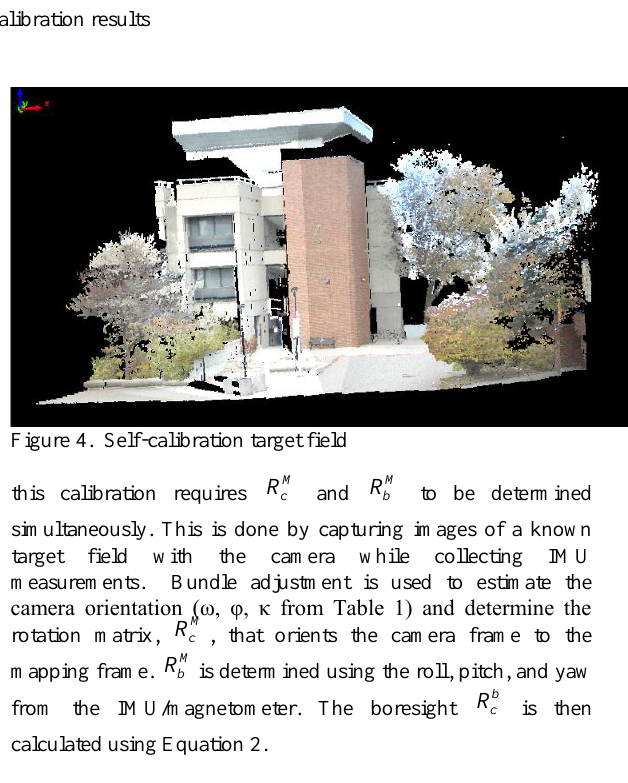
Table 2. Camera calibration results